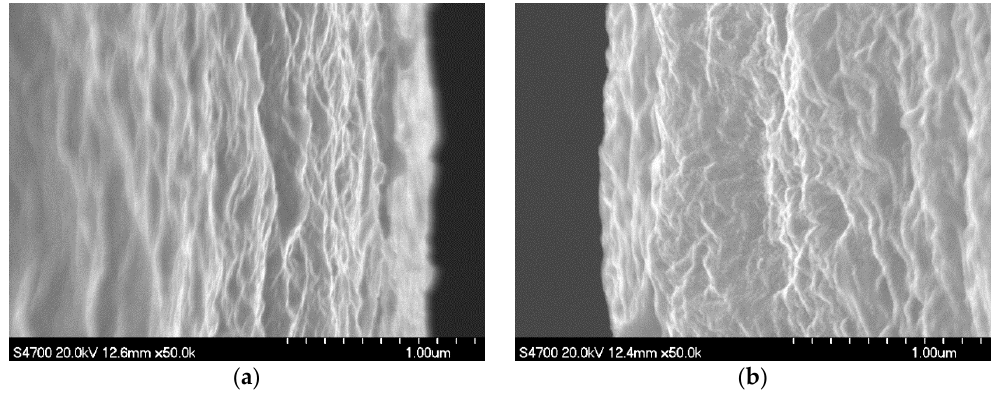
Figure 3. SEM images of as-spun filaments: ( a ) U/H blend as-spun filament samples with the initial draw ratio of 9; and ( b ) U as-spun filament samples with the initial draw ratio of 9.